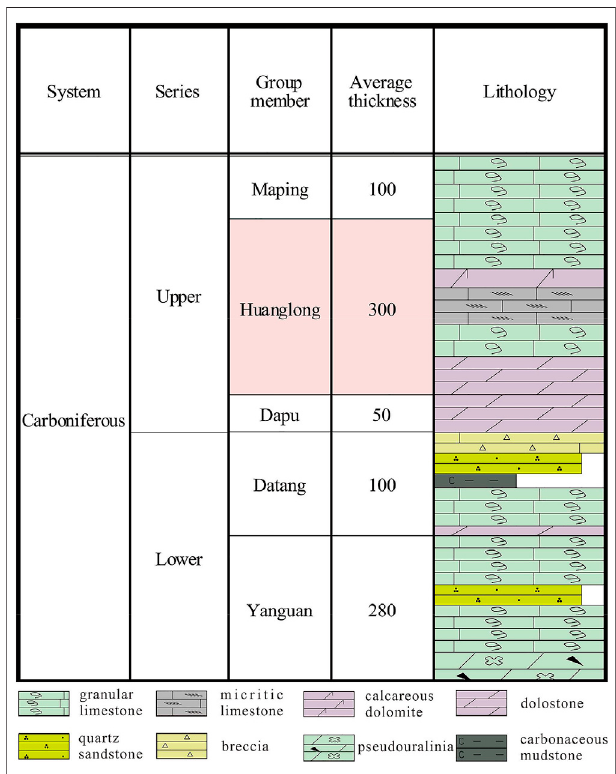
FIGURE 2 | Stratigraphic and lithology pro fi les of the Carboniferous strata in the Weixinan Depression.